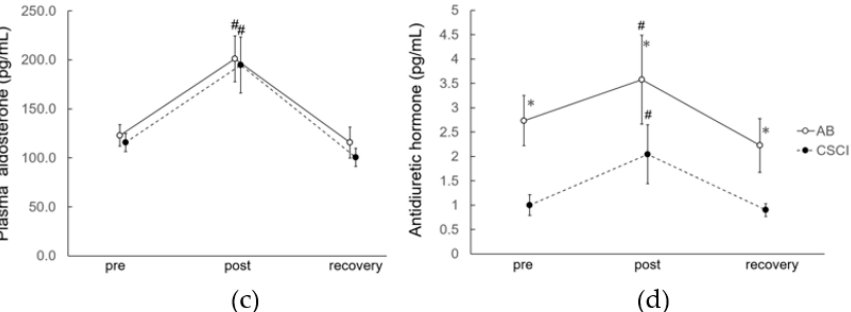
Figure 2. Plasma adrenaline, renin activity, aldosterone, and antidiuretic hormone before (pre), immediately after (post), and 60 min after (rec) exercise. Data are mean ± SEM. # p < 0.05 vs. pre value of the same subject group, * p < 0.05 vs. the value of CSCI at the same time period. Abbreviations as in Figure 1. ( a ) Plasma adrenaline level; ( b ) plasma renin activity; ( c ) plasma aldosterone level; and ( d ) plasma ADH.